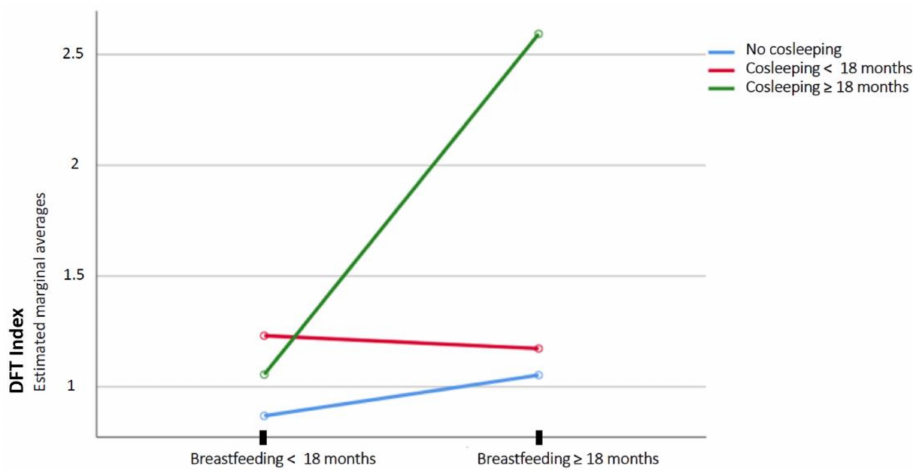
Figure 2. Interaction of the duration of cosleeping and duration of breastfeeding on the dft